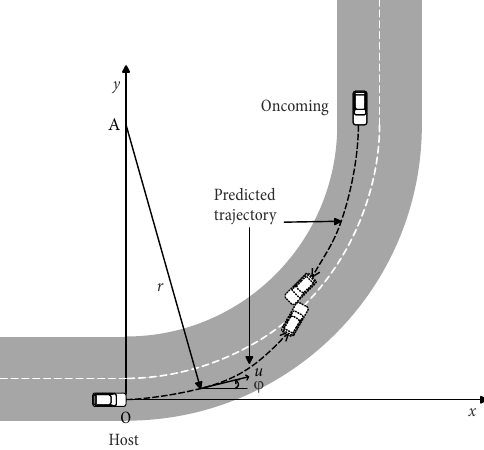
Fig. 1. Scenario of collision on curved